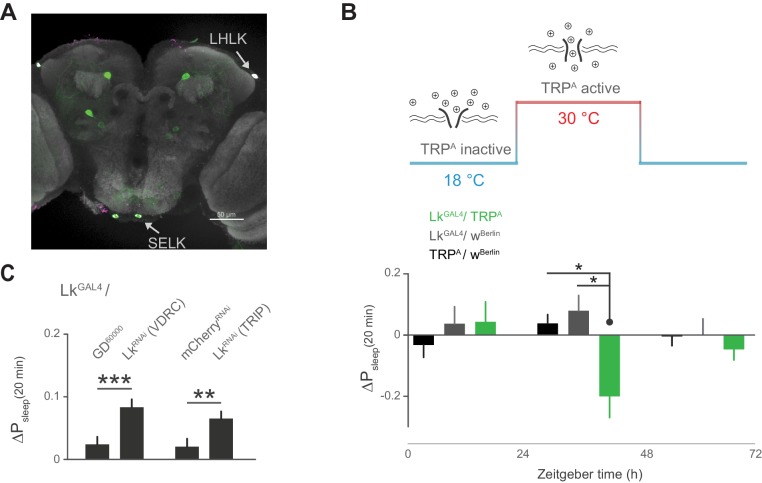
Leucokinin neurons inhibit postprandial sleep.(A) Confocal reconstruction of immunostaining for anti-Lk (magenta) in the brain of LkGAL4>mCD8::GFP reveals Lk co-localization with GFP-expressing neurons (green) in the lateral horn (LHLK) and suboesophageal ganglion (SELK). The neuropil marker nc82 (gray) is used as background (scale bar = 50 µm). (B) Stimulation of Lk neurons at 30°C by expressing Transient receptor potential channel, TrpA, causes a reduction in postprandial sleep in comparison to the unstimulated state at 18°C (10 flies per genotype, 30°C, n = 83 meals, TrpA/ wBerlin; 63, LkGAL4 / wBerlin; 25, LkGAL4 / TrpA; *p<0.05, Kruskal-Wallis test followed by Dunn’s multiple comparisons). (C) Downregulation of Lk in LkGAL4-labeled cells, using two independent RNAi lines, increases postprandial sleep. (60 flies per genotype, n = 893 meals, LkGAL4 / GD60000; 841, LkGAL4 / LkRNAi(VDRC); 953, LkGAL4 /mCherryRNAi; 1060, LkGAL4 / LkRNAi(TRIP); **p<0.01, ***p<0.001 Mann-Whitney test).